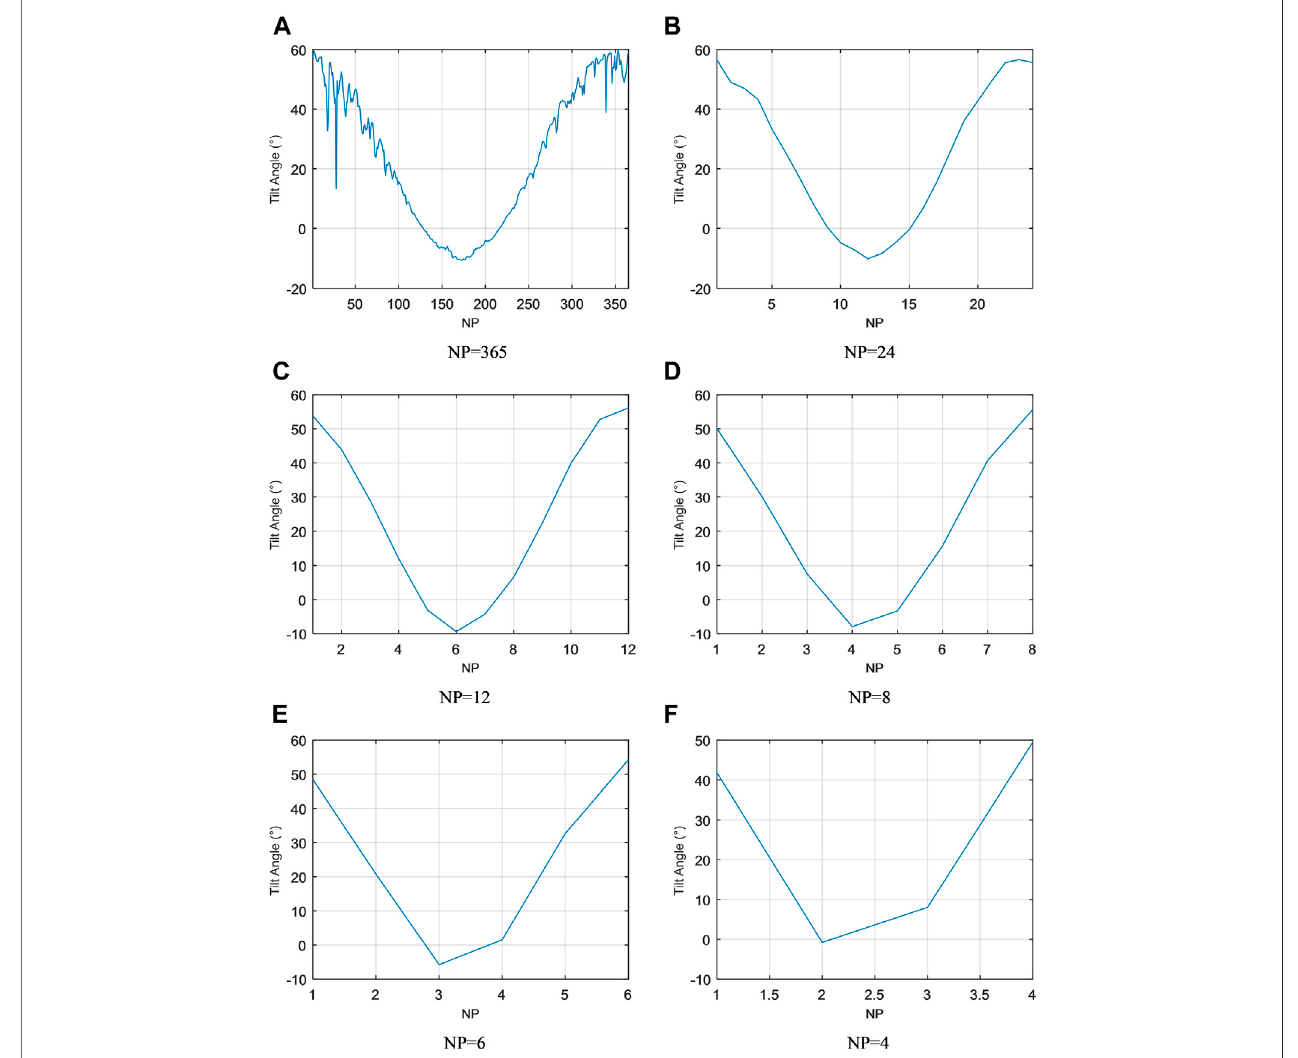
FIGURE 3 | Optimum tilt angle estimates for various NPs for Yanbu using model